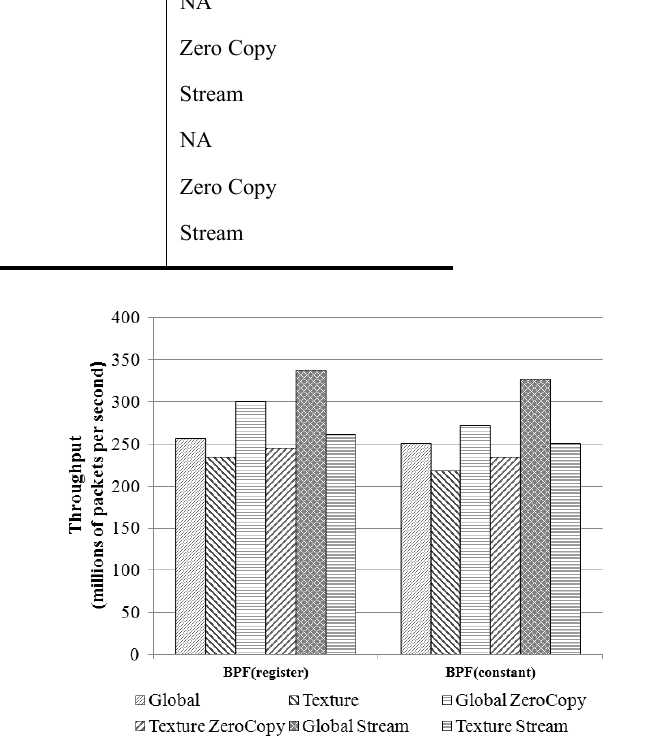
Fig. 12. Throughput comparison between memory usages on GPU-based BPF algorithm.